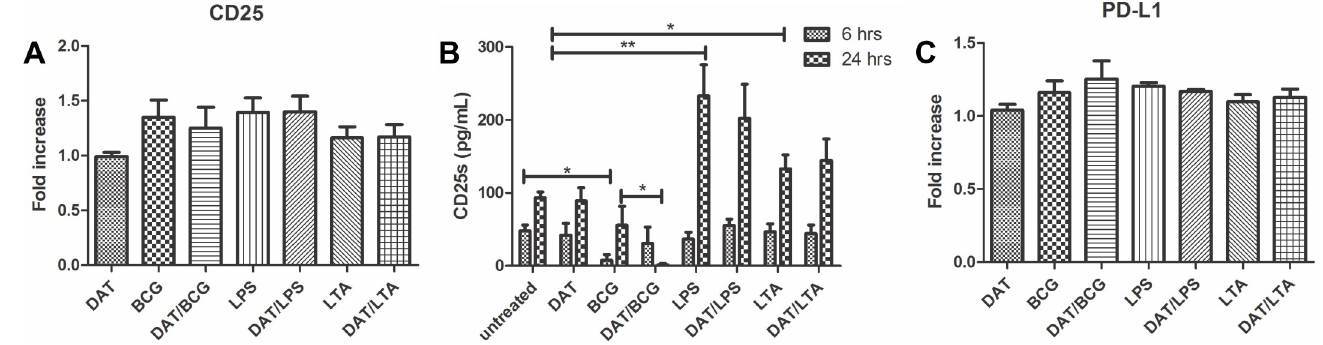
Fig 7. Effects of Di- O -acyl trehalose in the expression of coinhibitory molecules. Since an immunoregulatory function for CD25 has been proposed, we analyzed its expression by FACS and ELISA. A small increase in CD25 surface expression in DCs treated with BCG and TLR agonists with or without DAT (A). ELISA of supernatants showed increased levels of CD25s in DCs treated with LPS and with LTA at 24 h of culture (p < 0.05; unpaired t Student’s test) (B). The expression of PD-L1 was similar in basal and experimental conditions (C).